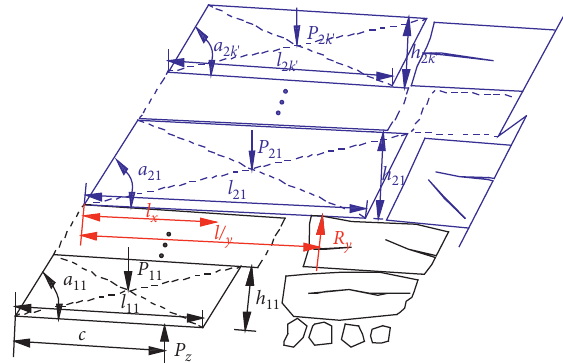
Figure 9: Nonhinged roof structure of bearing system under stress.